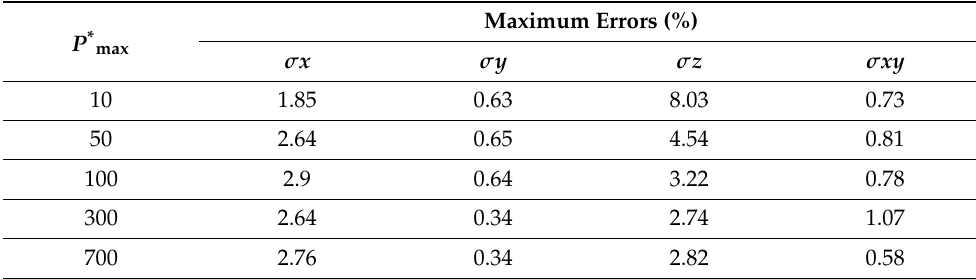
Table A2. The R 2 goodness-of-fit of the empirical formulas for the loading and unloading process fitting P * vs. ω * and A * vs. ω * obtained from the elastic–plastic FE model.